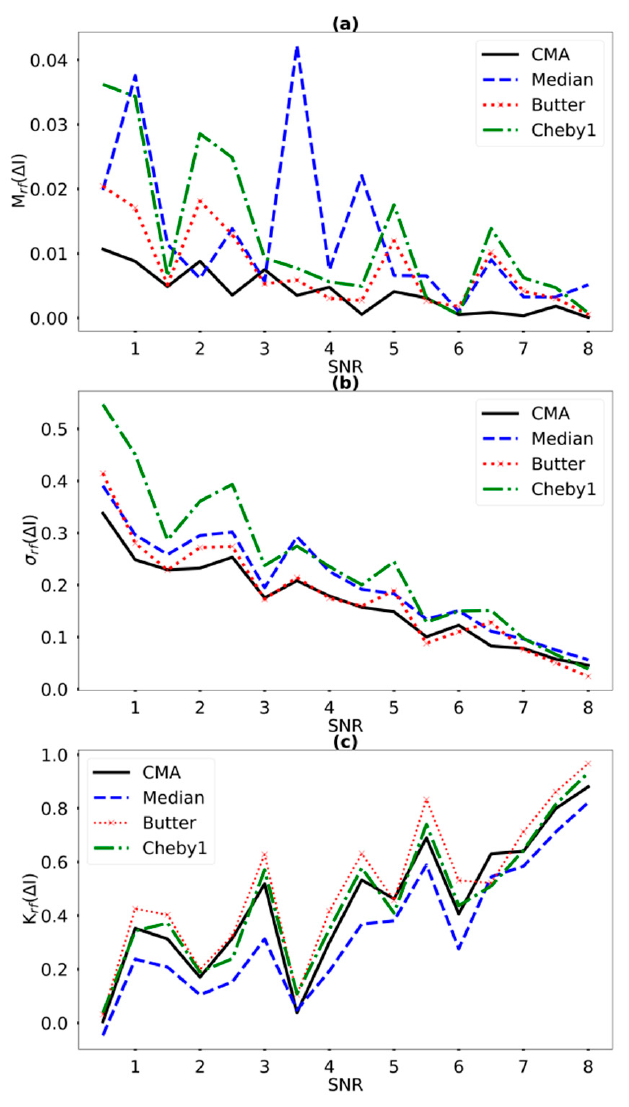
Figure 9. Dependence of the ( a ) M RF , ( b ) σ RF , ( c ) K RF selection quality criteria on the white-noise amplitude.